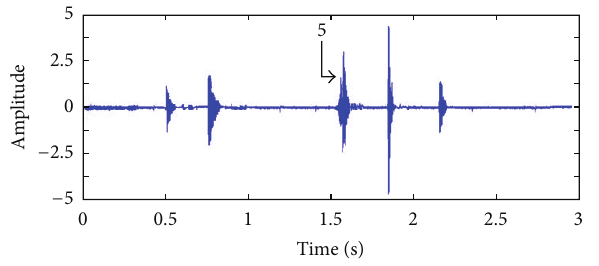
Figure 10: Typical acoustic emission signal with expulsion.